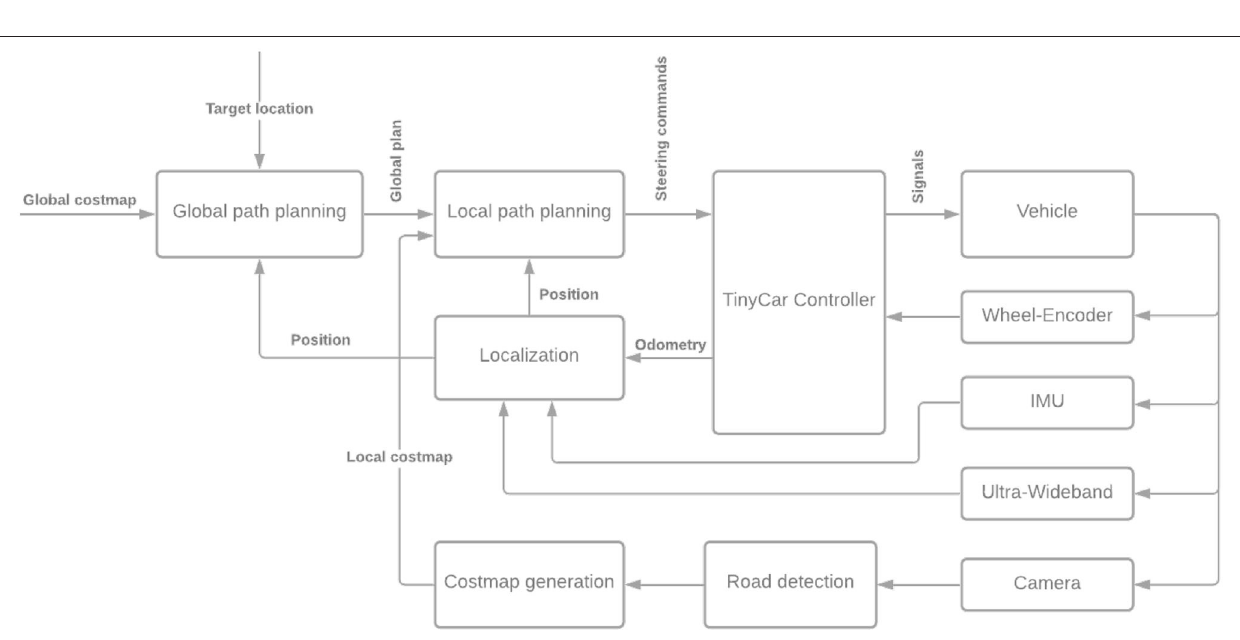
FIGURE 7 | System architecture developed for the algorithm under test